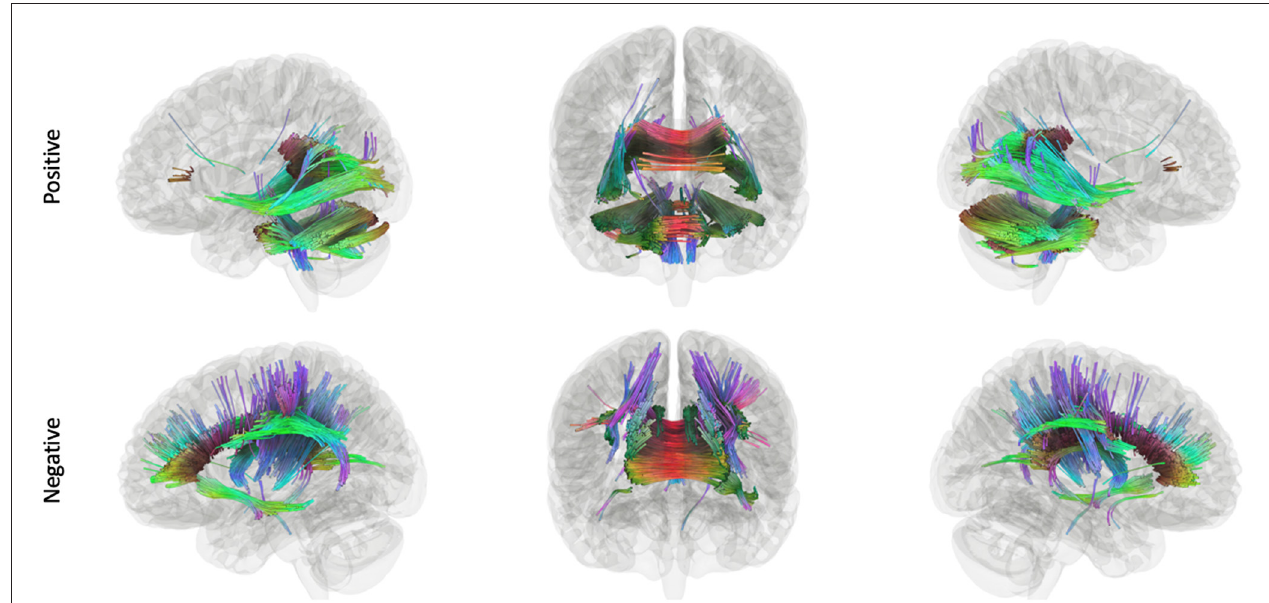
FIGURE 4 | Tracks positively and negatively associated with composite language performance within the EPT group. Tracts that were positively (top row) and negatively (bottom row) correlated with language performance, controlling for WNV, within EPT (t = 2.5, length threshold = 20 voxels, FDR = 0.05, 4,000 permutations, 2 rounds of tract trimming). There is a clear dichotomy of superior tracts traditionally correlated with language (left arcuate fasciculus, corpus callosum, left lateral fronto-occipital fasciculus, etc.) that are negatively correlated in EPT. Inferior and posterior tracts that are not typically associated with language (posterior inferior fronto-occipital fasciculus, cerebellum, cerebellar peduncles, splenium) that are positively associated with language